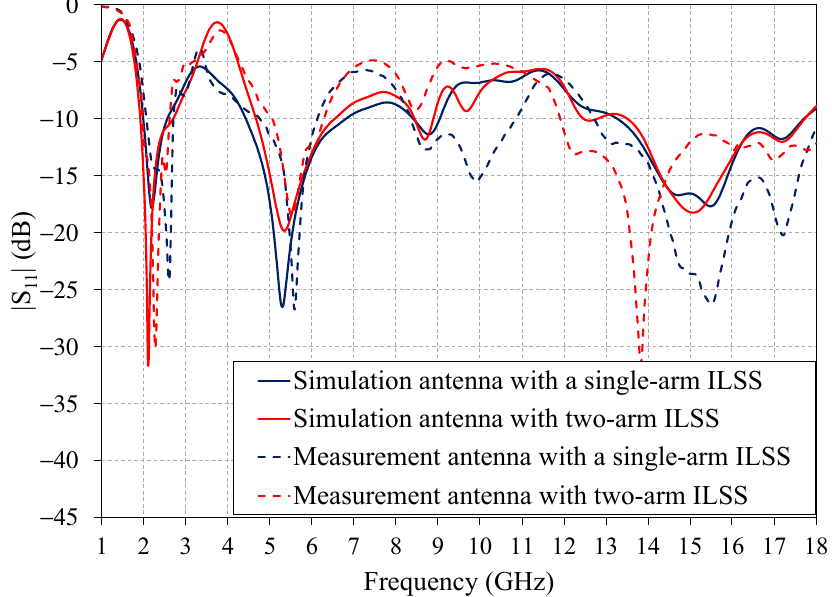
Figure 10. Simulated and measured |S 11 | of the proposed antenna with a single-arm and two-arm ILSSs.